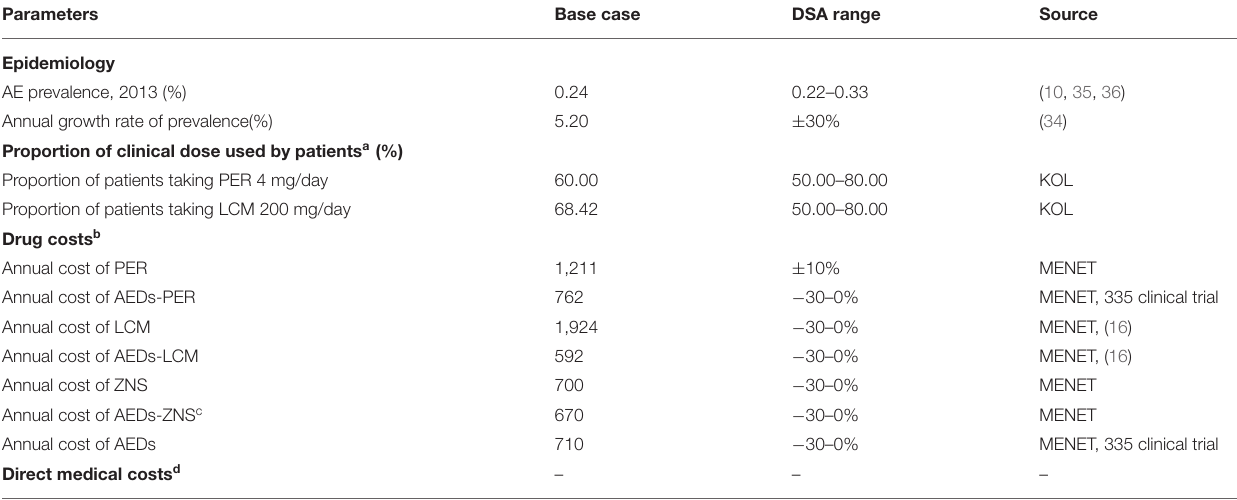
TABLE 5 | Inputs in the BI model.